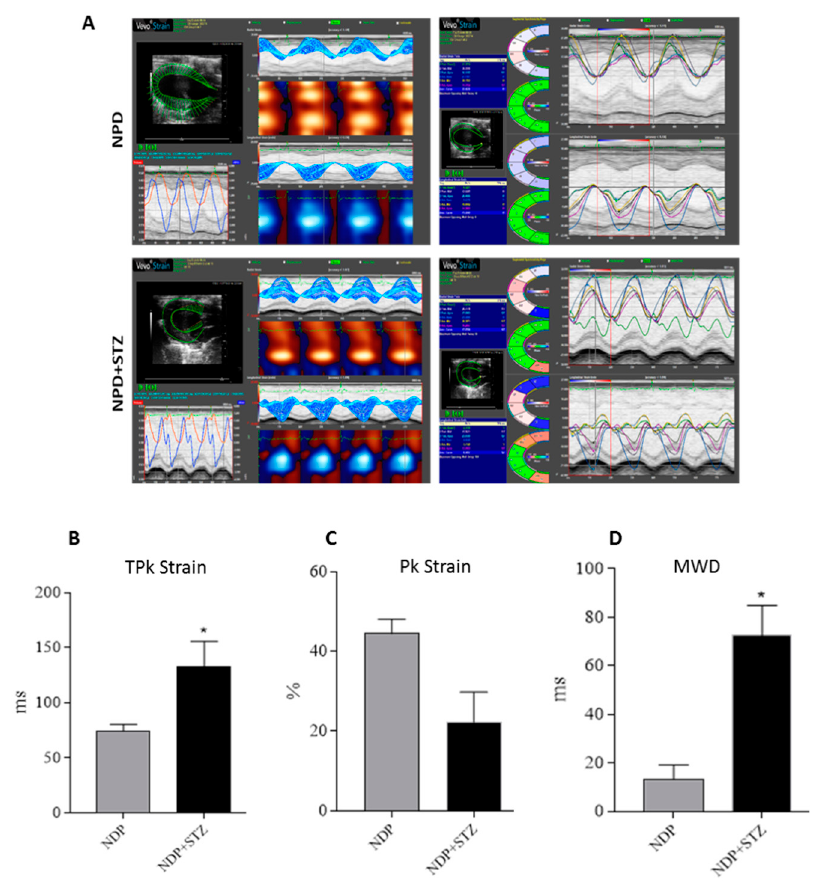
Figure 2. Cardiac tissue strain analysis. ( A ) Representative parametric displays, area / volume graphs, and segmental synchronicity page related to endocardial strain analysis of parasternal short ‐ axis view (PSLAX) assessed in radial motion at the end of experimental period. ( B ) Average of time ‐ to ‐ peak (TPk) of the six segments of cardiac wall in endocardial strain analysis. ( C ) Whole peak capacity, assessed as the peak average (Pk) of the six segments of cardiac wall, in endocardial strain. ( D ) Maximum wall delay (MWD) of LV during radial motion in endocardial strain analysis. The data are presented as mean ± SEM. * p < 0.05 vs. NPD, Mann–Whitney test, n = 6/group.